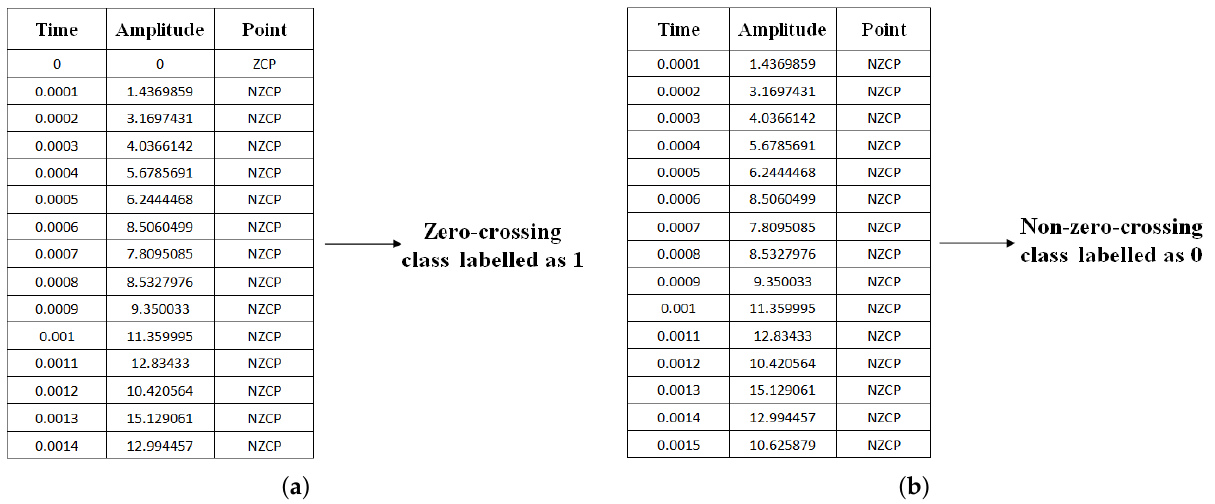
Figure 5. Data sampling from sinusoidal signals with window size of 15. ( a ) Data window corresponds to ZCP class. ( b ) Data window corresponds to NZCP